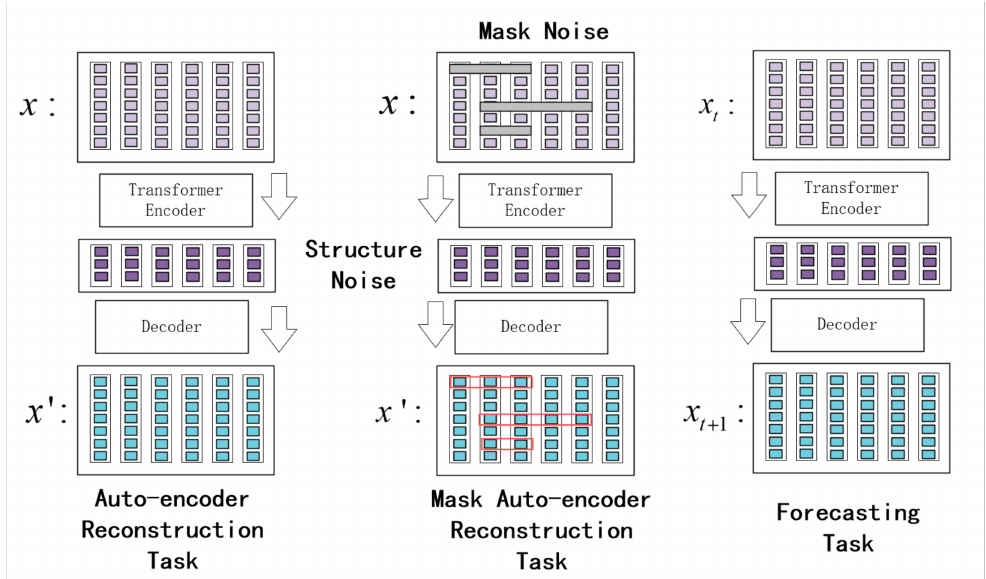
Figure 5. Simple demonstration of different SSL